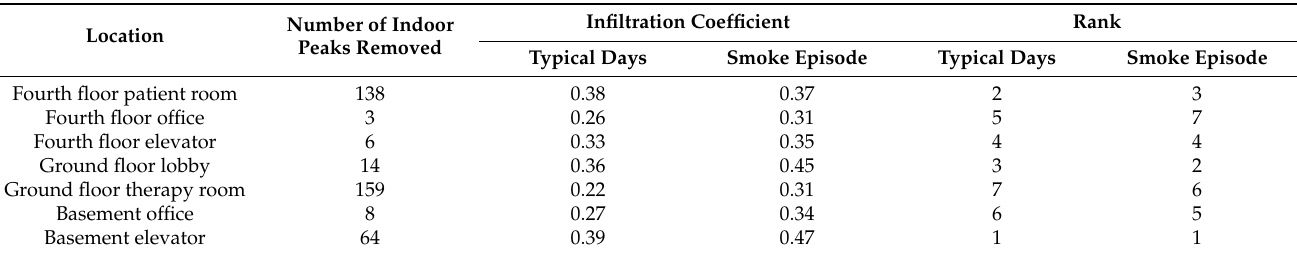
Table 2. Infiltration coefficients and their relative ranks for indoor locations in the rehabilitation center after removing indoor peaks during the smoke episode and typical days.